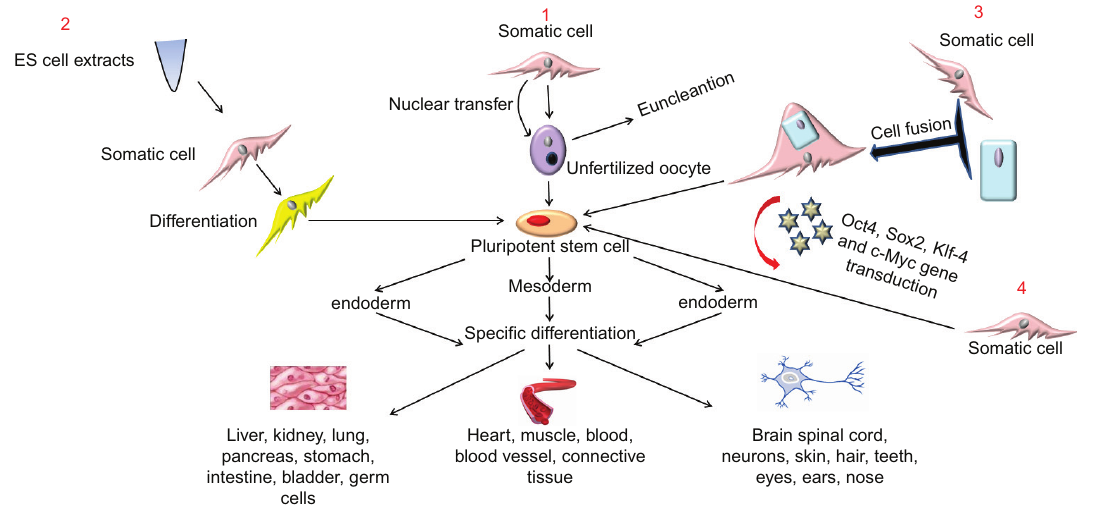
Figure 1. Approaches for creating reprogrammed cells from somatic cells. 1: Somatic cell nuclear transfer into oocyte; 2, adding embryonic stem cell (ES) extract to somatic cells; 3: somatic and ES cell fusion; and 4: transduction of pluripotency genes. Gen- erated reprogrammed cells from each strategy can create three germ layers known as ectoderm, endoderm, and mesoderm. Induced redifferentiation of these reprogrammed cells can provide functional calls and